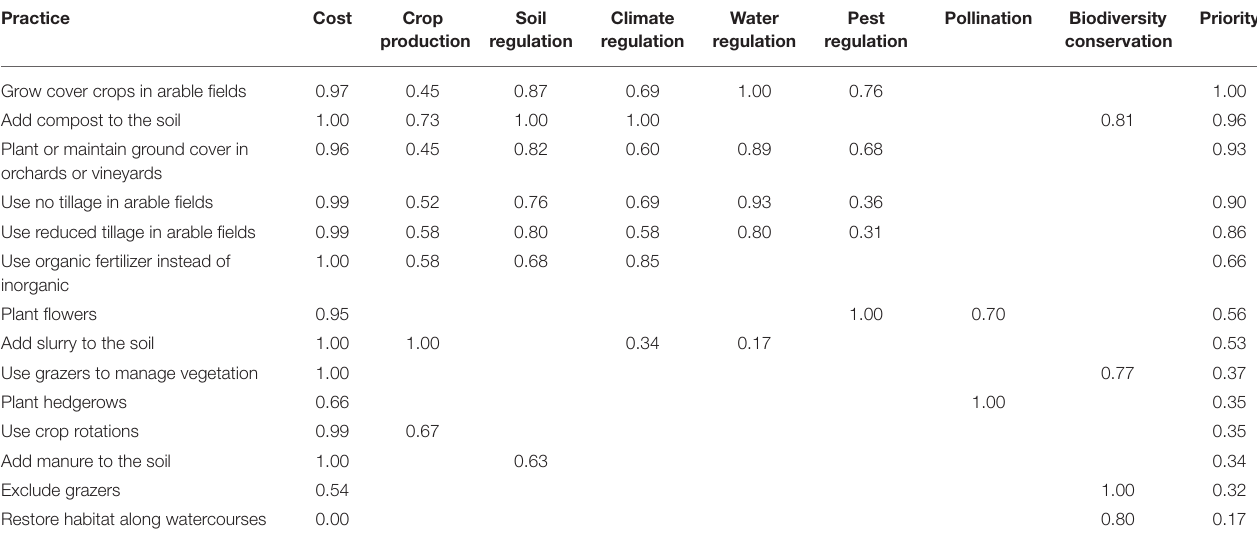
TABLE 3 | Best management practices (BMPs) for farmland and/or rangeland in California and other Mediterranean farming systems: priority scores in the equal-weight scenario (but see the Discussion for the limitations of this prototype).